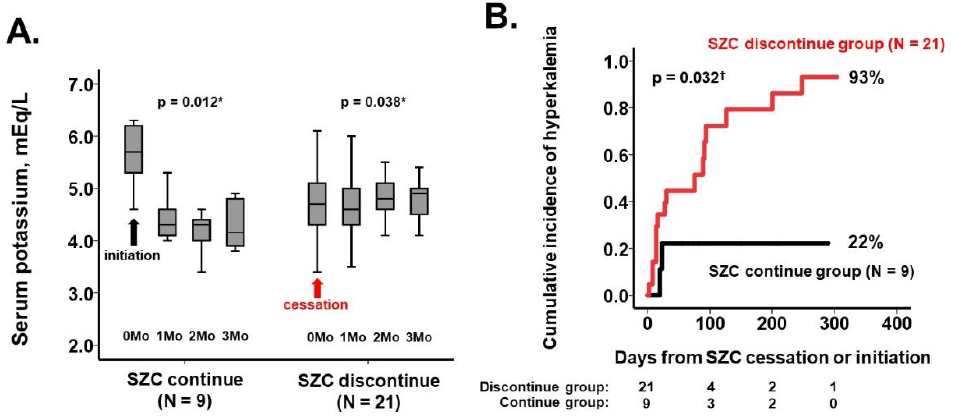
Figure 1. Trends of serum potassium levels for three months following the secession or initiation of SZC ( A ). One-year cumulative incidence of recurrent hyperkalemia in the SZC discontinue group and the SZC continue group ( B ). * p < 0.05 by Friedman tests for trend analyses. † p < 0.05 by log-rank test.